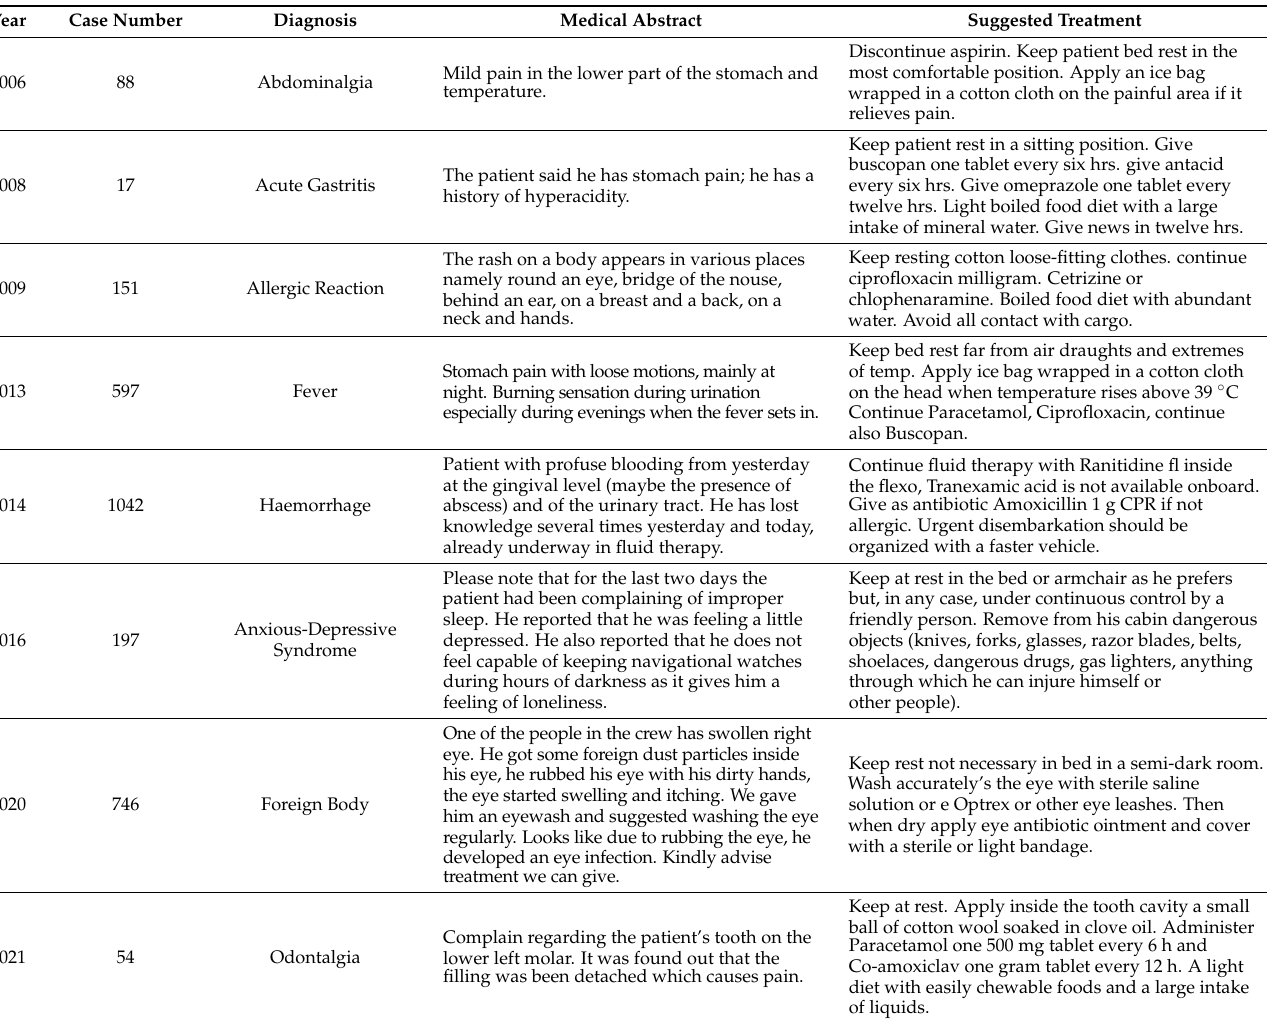
Table 1. Sample of medical abstracts and treatment of given